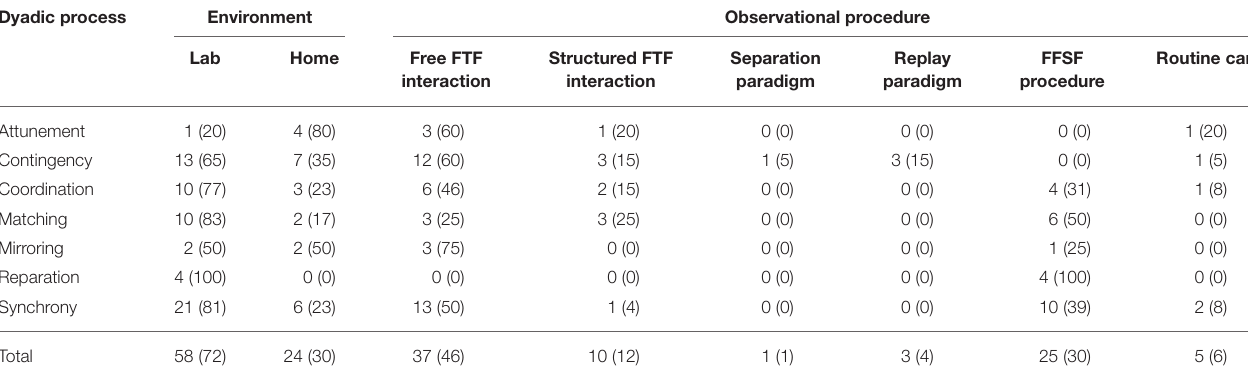
TABLE 4 | Setting of the included studies (percentages reported in